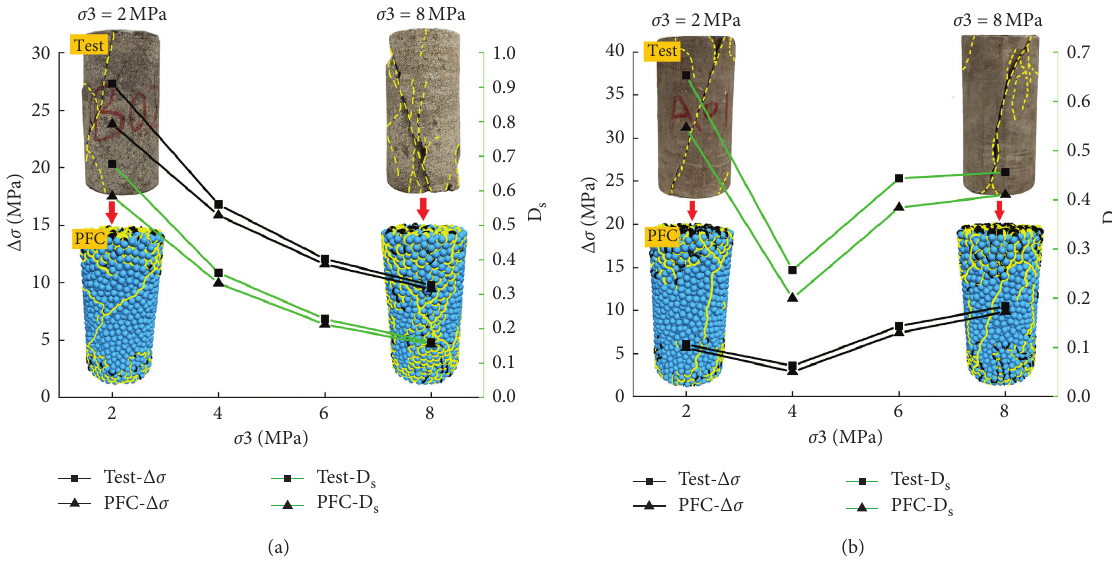
Figure 7: Comparison of rock attenuation value Δ σ , attenuation coefficient D